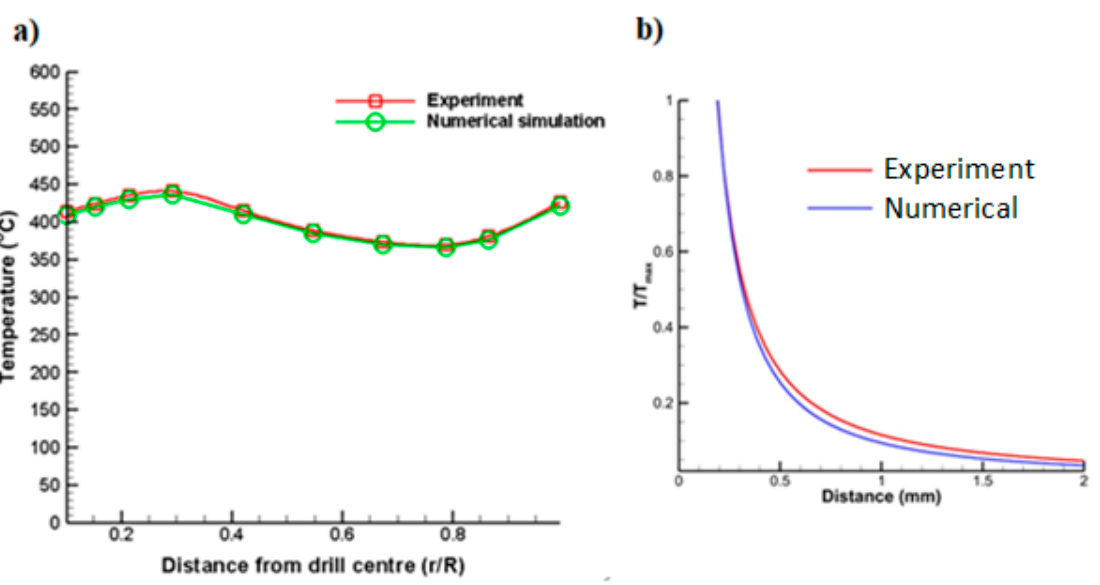
Figure 4. Temperature plots validated with ( a ) experimental results of Zhu et al. [33], ( b ) experimental results of Khan et al. [44].